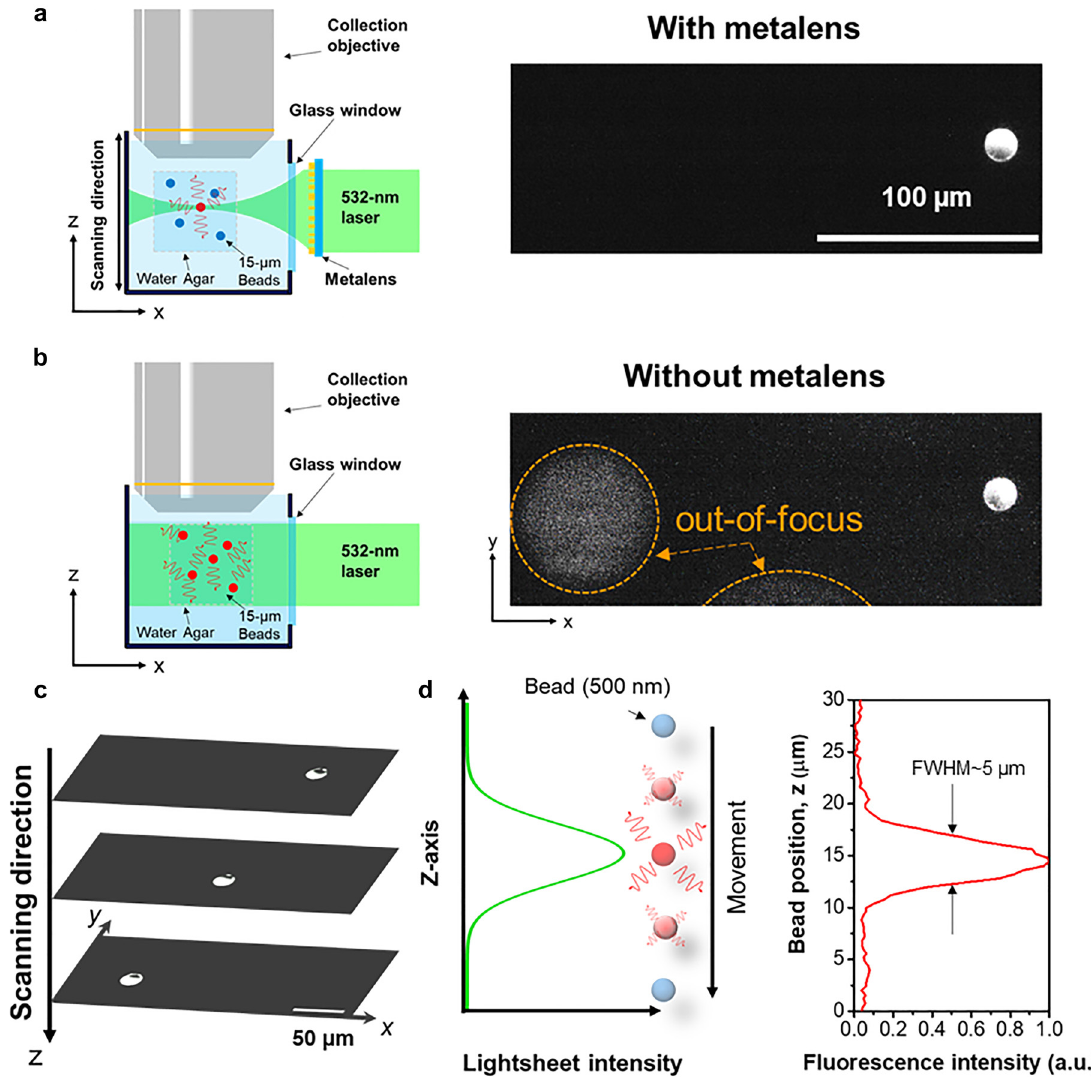
Figure 2: Characterization of the meta-lens-equipped LSFM system. Comparison of imaging performance using 15-µm fl uorescent beads (a) with and (b) without the meta-lens. Left panels in (a) and (b) are schematic diagrams of the setup, and the corresponding fl uorescence imagesarepresentedintherightpanels.(c)Lightsheetscanningalongthe z -axis(withthemeta-lens),threeindividualbeadscanbeobserved at three different layers, without any obvious out-of-focus background. (d) Optical sectioning capability test by using a 0.5-µm fl uorescent bead. Left: a schematic diagram of the measurement. Right: the corresponding fl uorescent intensity pro fi le at different